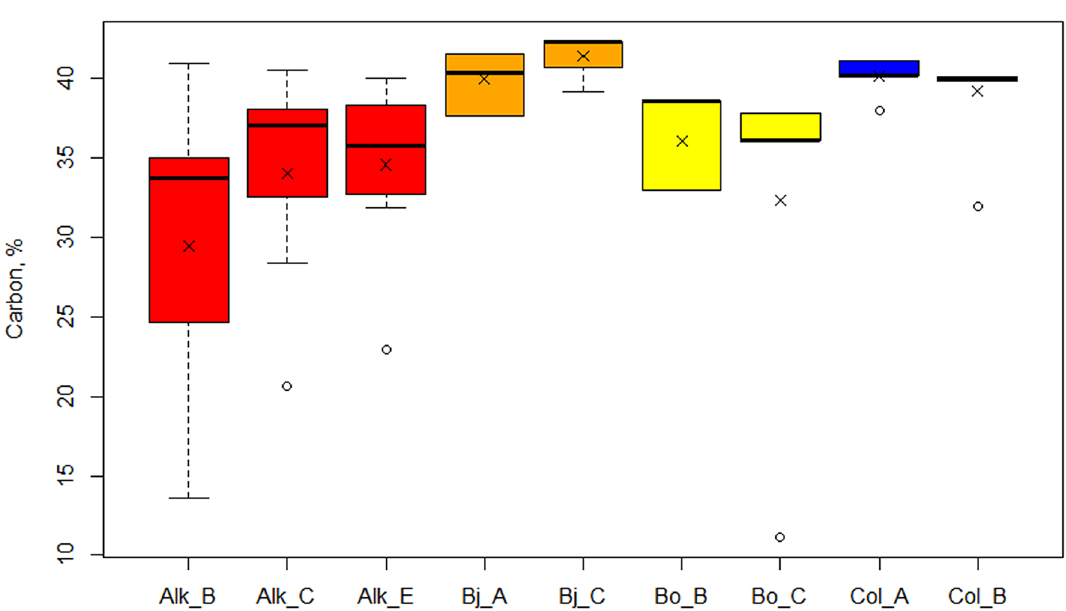
Figure 12. Carbon content (%) for the focus section study points. The × marks mean value and the vertical line median value. Where applicable, whiskers represent 1st and 3rd quartile. Outliers are shown as dots outside the